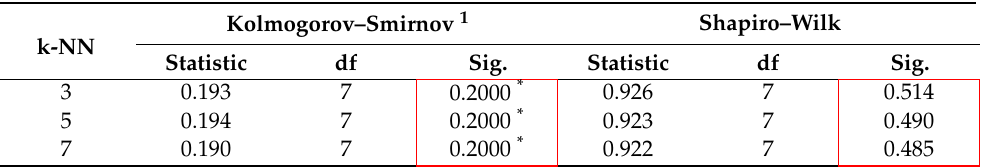
Table 1. Results of the normality test with the k value as 3, 5, and 7 (average prediction time for each